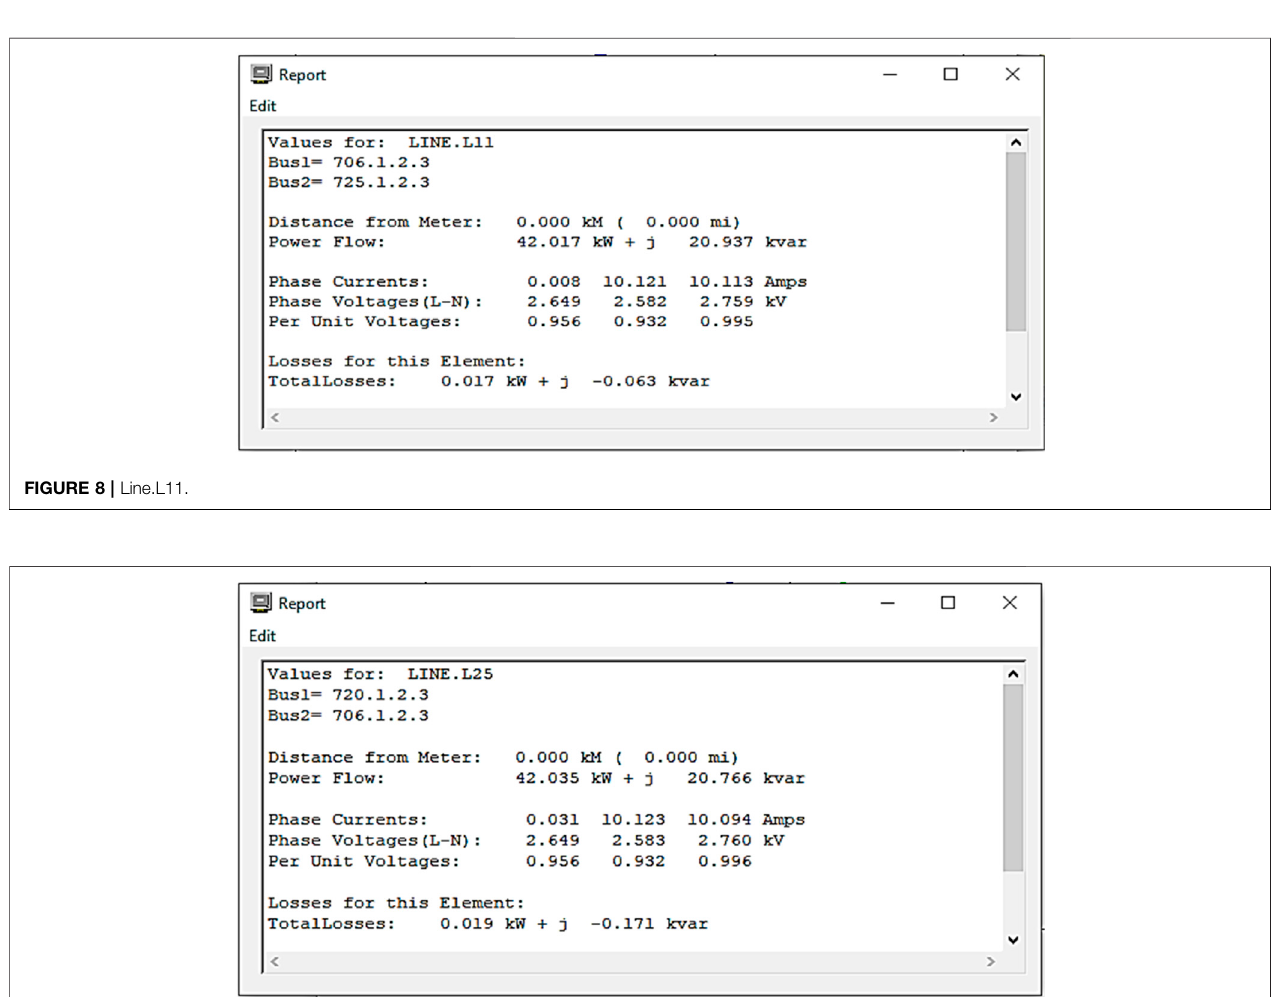
FIGURE 7 | Line power.